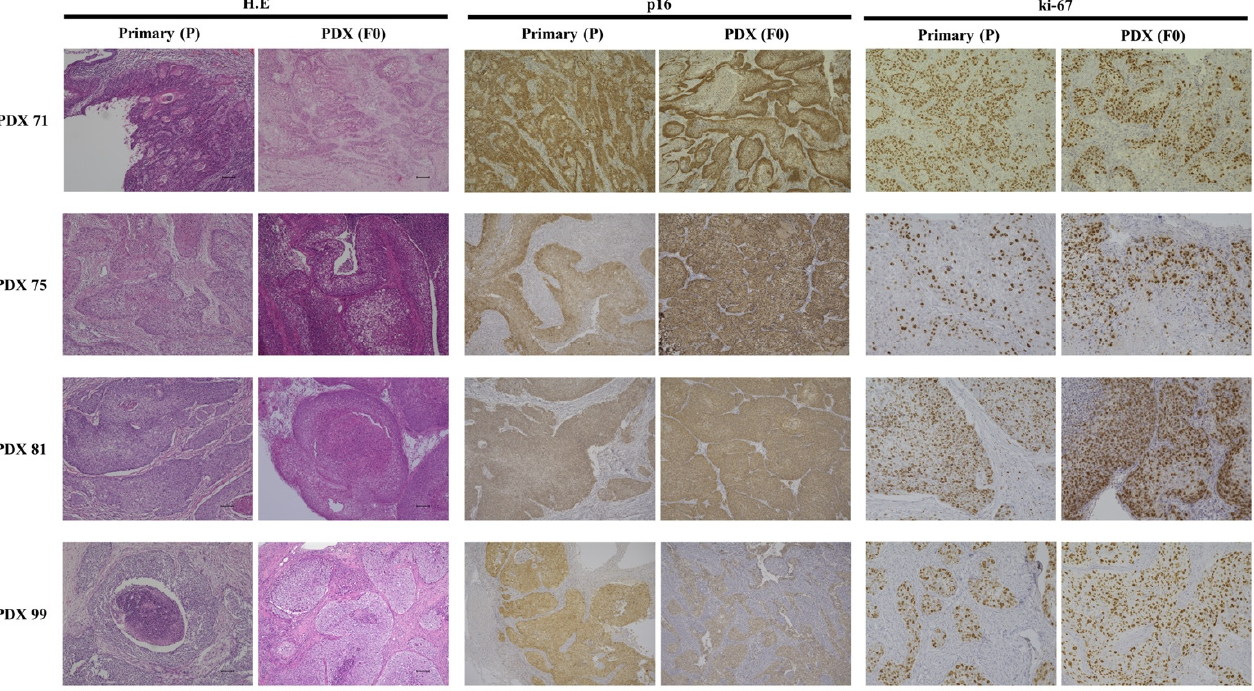
Figure 3. Pathological findings with immunohistochemistry of primary and PDX models (PDX 71, 75, 81, and 99). Tumor cells show angular and irregularly sized and shaped nests, anastomotic cord, and solid sheet interstitial infiltration. Nuclear pleomorphism and an increased mitotic count are observed in primary and PDX models. Immunohistochemical patterns are similar for p16 and ki67 between the primary and PDX tumors. Scale bar = 100 μ m.